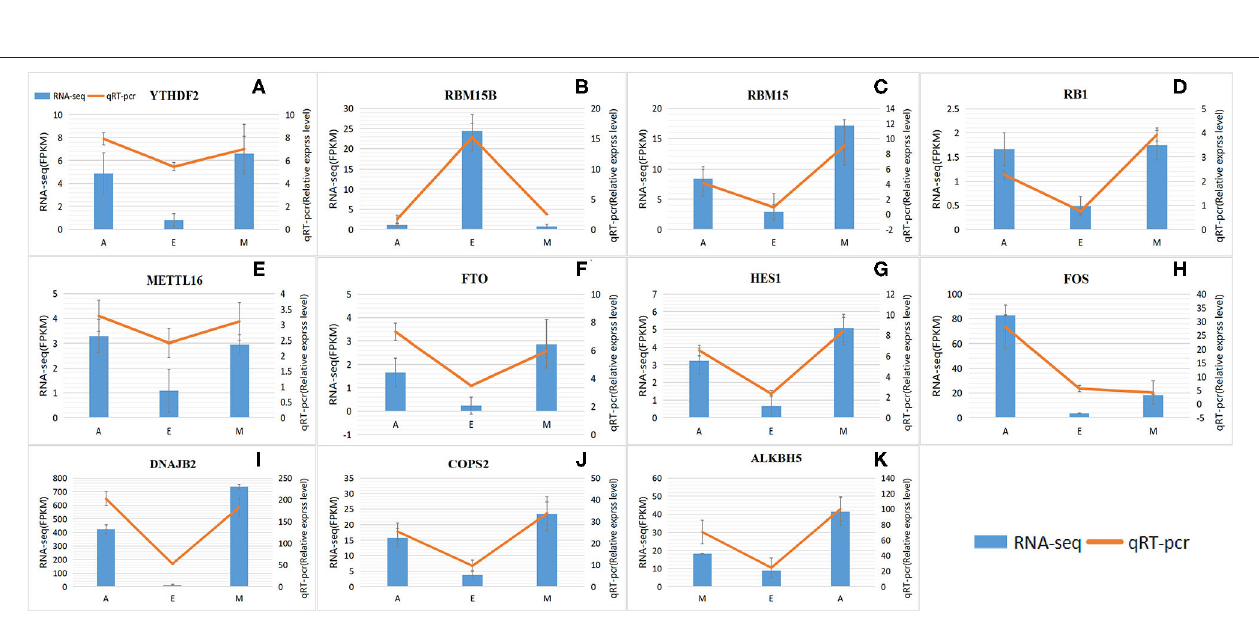
FIGURE 6 | Enrichment analysis of the negatively correlated modified genes in each group. (A–C) The KEGG analysis in AvE, MvA, and MvE. (D–F) The GO analysis in AvE, MvA, and MvE.